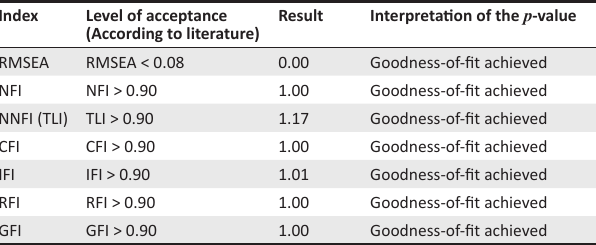
TABLE 8: Interpretation of budget management.